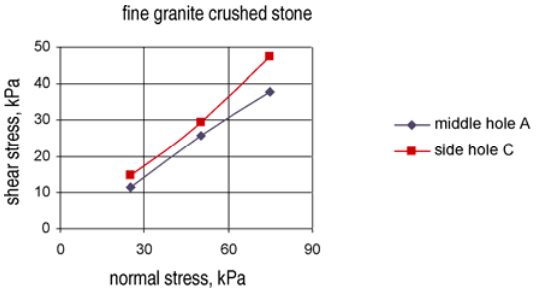
Fig 14 . Distribution of horizontal component of stress x σ during the test of sand sample